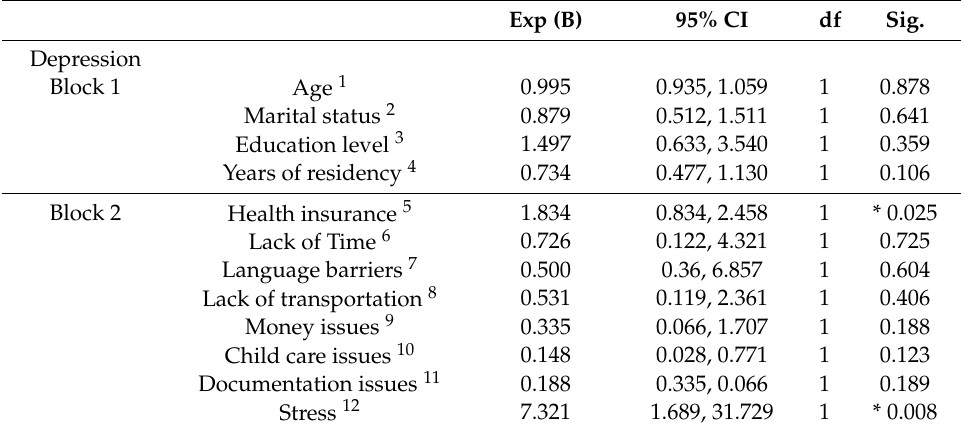
Table 3. Logistic regression model for identifying significant covariates for depressive symptoms among participants. Exp (B) 95% CI df